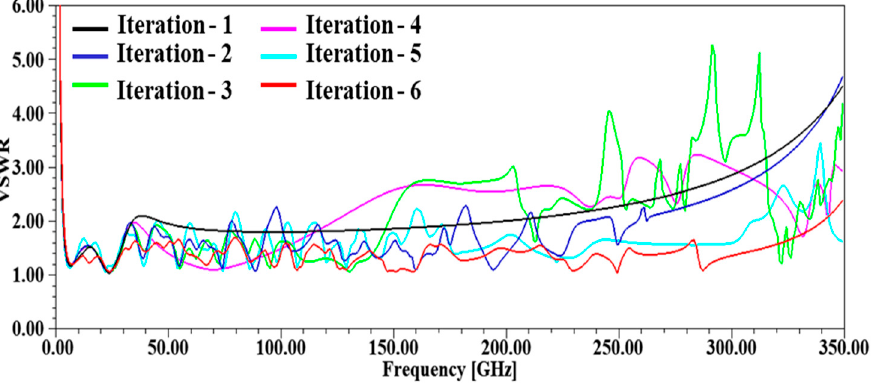
Figure 4. VSWR of the proposed antenna.